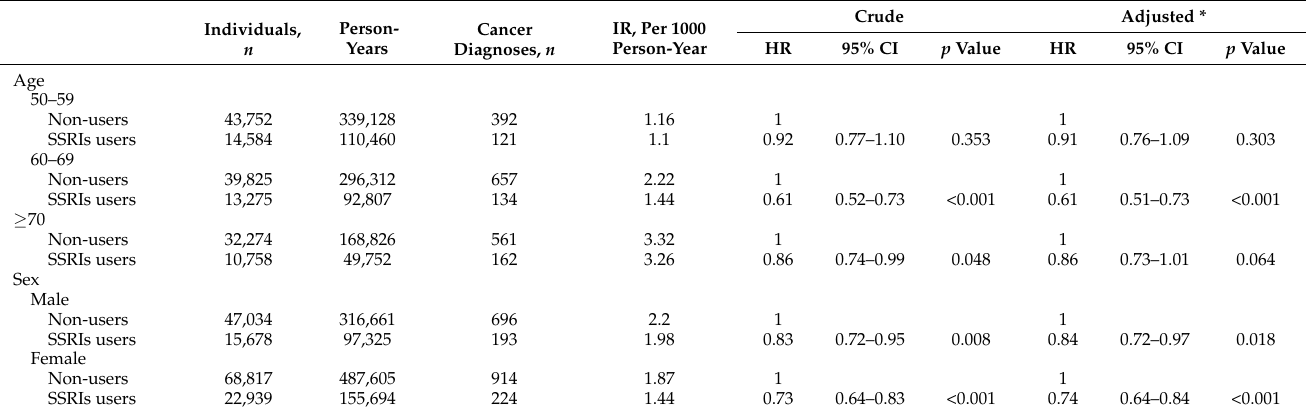
Table 3. Hazard ratios and 95% confidence intervals of different types of colorectal cancer associated with SSRI use among individuals with a family history of CRC, stratified by age and sex.